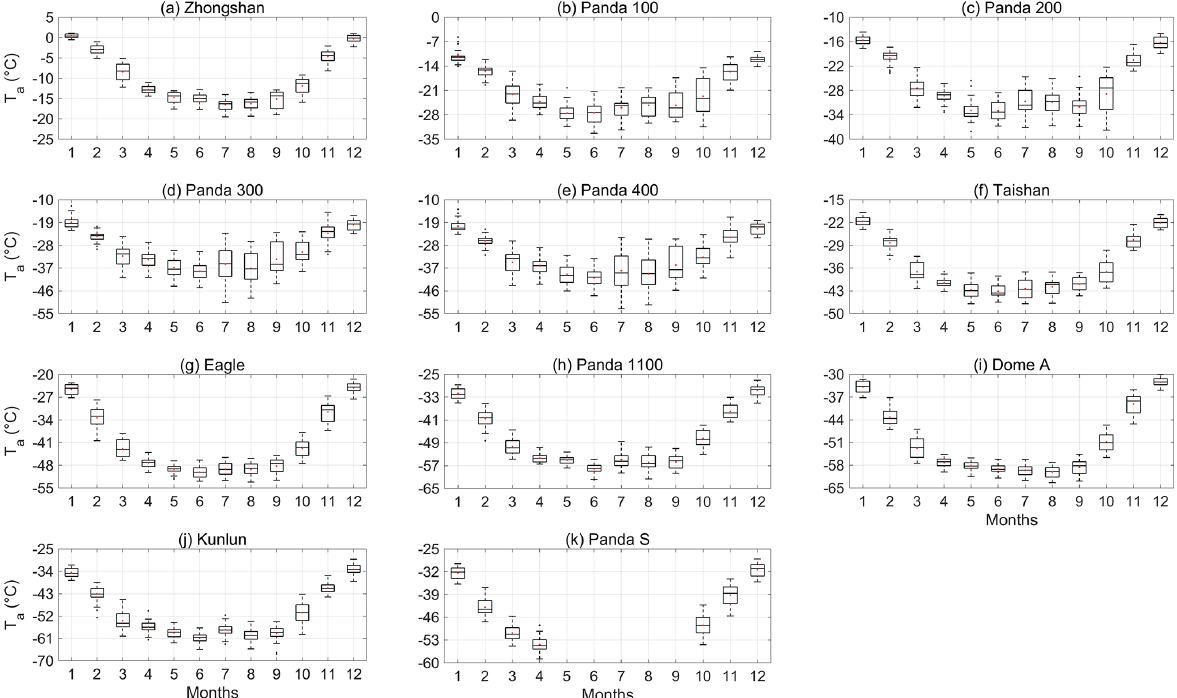
Figure 4. Variation in monthly mean air temperature at AWSs in the PANDA network. The calculation periods for these sites are the same as for Fig. 3. For each monthly box, the central line indicates the median; the red dot represents the mean; and the bottom and top edges of the box indicate the 25th and 75th percentiles, respectively.